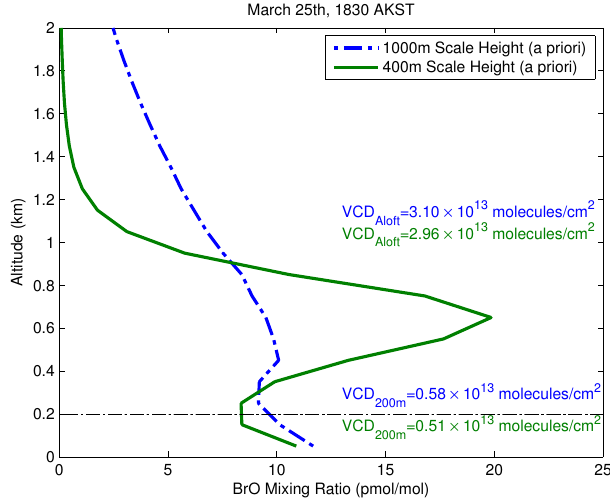
Figure 1. A sample profile retrieval of BrO at the BARC building. The blue line represents the profile retrieved using an a priori pro- file that exponentially decays with a scale height of 1000m, while the green represents quantities retrieved using an a priori profile that exponentially decays with a scale height of 400m (a priori used for this study). The dashed lines indicate layer boundaries determined from the ensemble of retrievals over the course of this study. The partial VCD values noted inn the figure correspond to layer selec- tions used in this study. The VCD 200m is the integral of the re- trieved profile from 0 to 200m and the VCD Aloft is integrated from 200 to